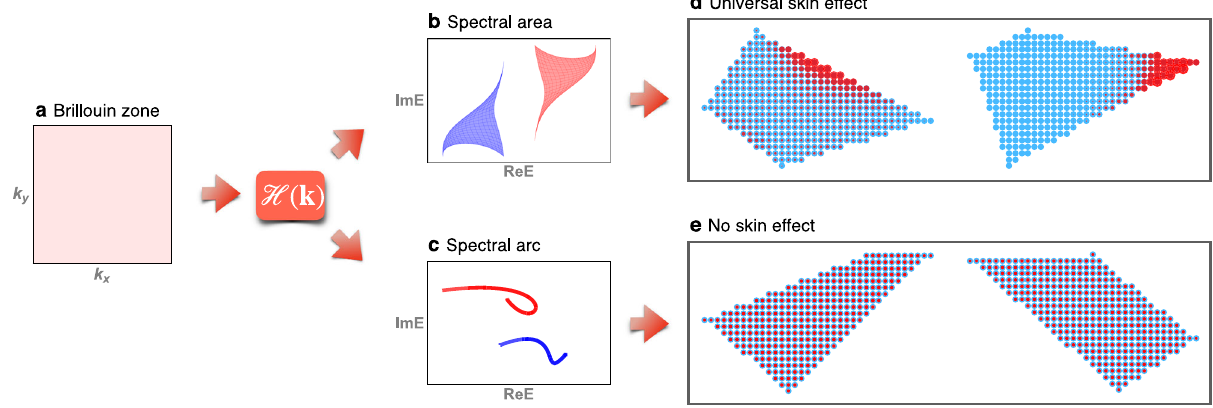
Fig. 1 The theorem of universal skin effect. a represents the Brillouin zone. b , d shows that if the spectral area of H ð k Þ is nonzero, the skin effect will appear on some generic open-boundary geometries. c , e shows that when the spectral area of H ð k Þ is zero, or forming one or several arcs on the complex plane, there is no skin effect under